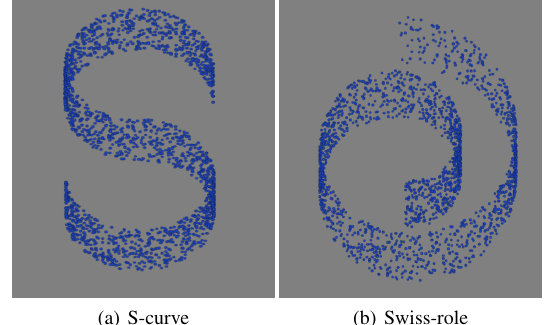
Figure 3: Our synthetic data has been drawn randomly from 2D S-curve and Swiss-role embedded in 3D.